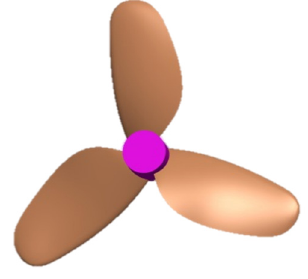
Figure 6. Three-dimensional model of the blade.